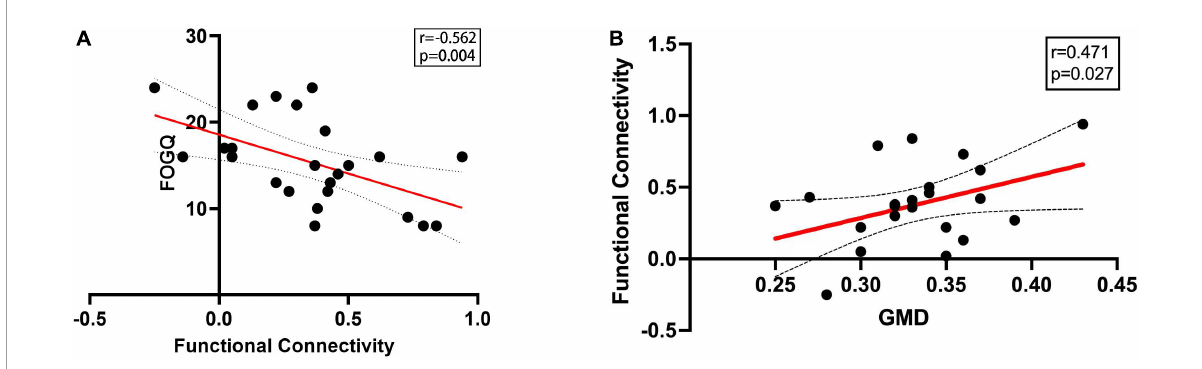
FIGURE2 Correlation between FOGQ score, GMD and functional connectivity. (A) The functional connectivity between right superior occipital gyrus and right paracentral lobule was negatively associated with FOGQ score. (B) The functional connectivity between right superior occipital gyrus and right paracentral lobule was positively correlated with GMD of right superior occipital gyrus in PD-FOG. GMD, gray matter density; FOGQ, freezing of gait